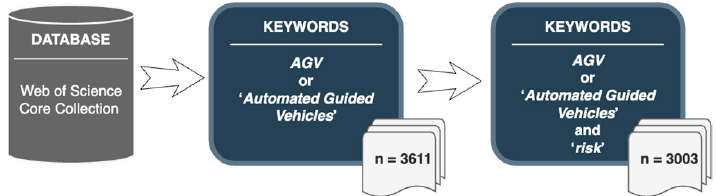
Figure 1. Identification stage.